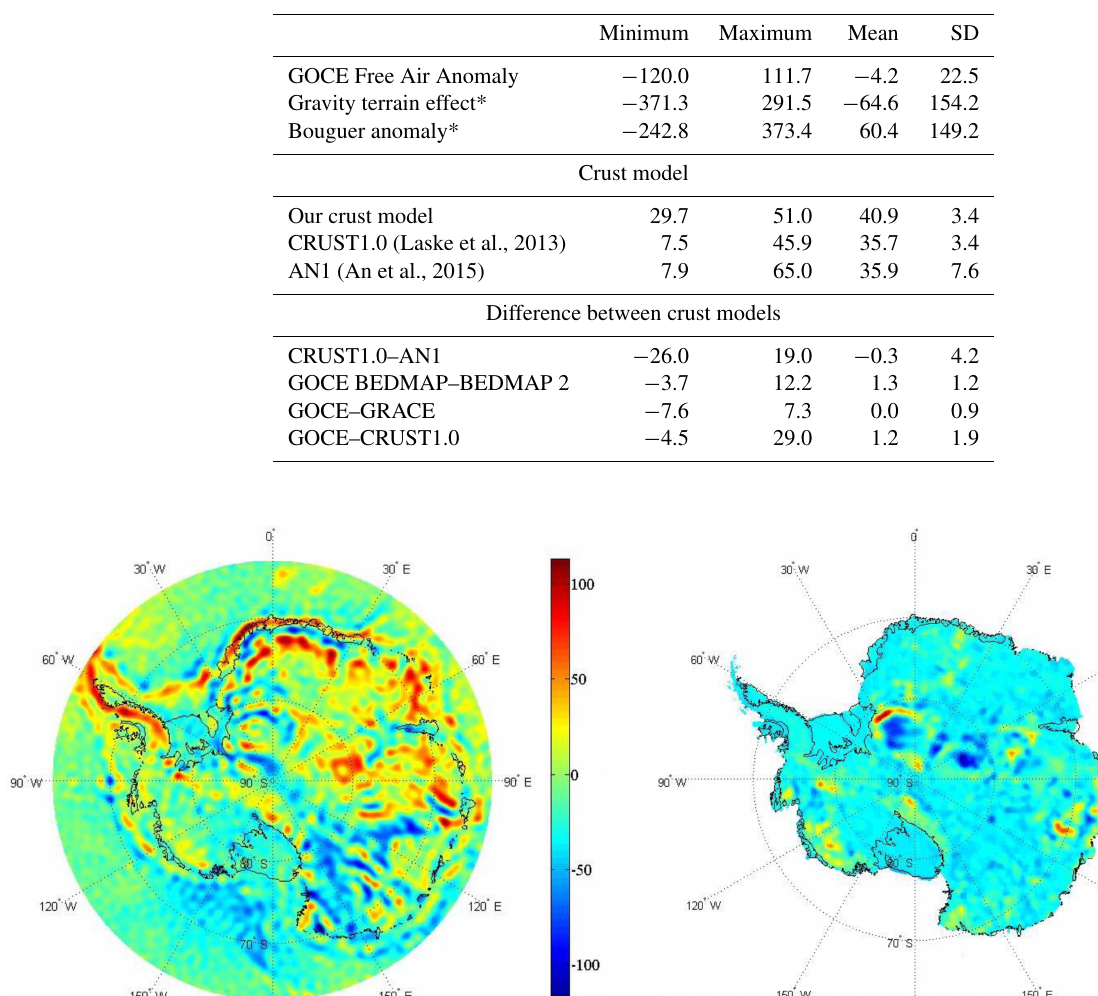
Table 1. Statistical data for maps used in this study. The first three rows are in milligals (mGal), and the others are in kilometers (km). The ∗ indicates the application of a 77km low-pass filter.